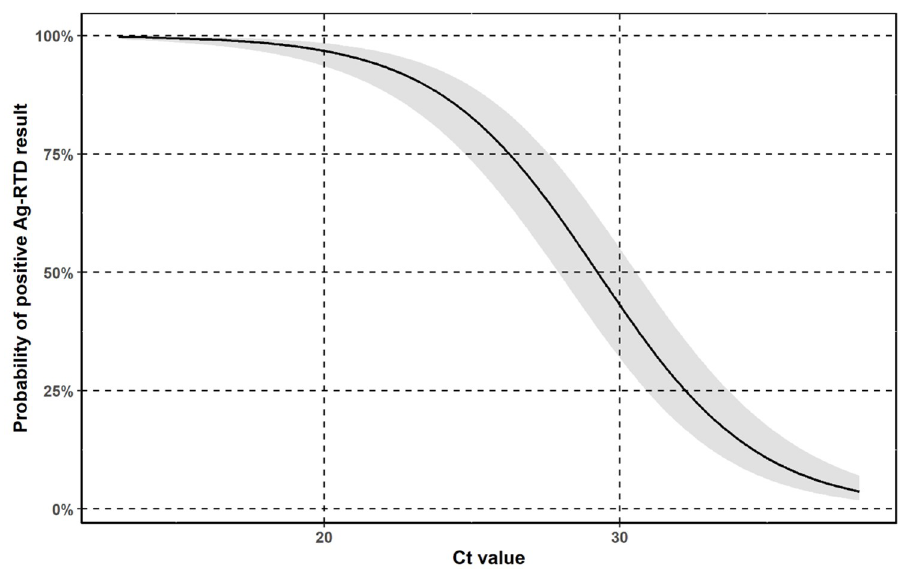
Fig 4. Probability of a positive Ag-RTD result by positive RT-qPCR Ct values. Probability of a true positive Ag- RTD test among Ct values with its 95% confidence interval.